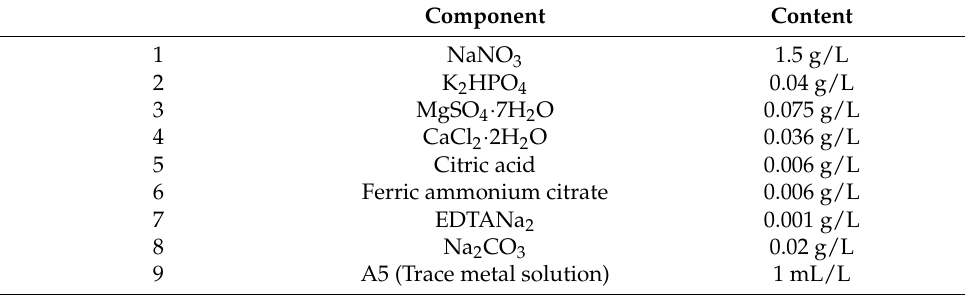
Table 1. The medium formula of